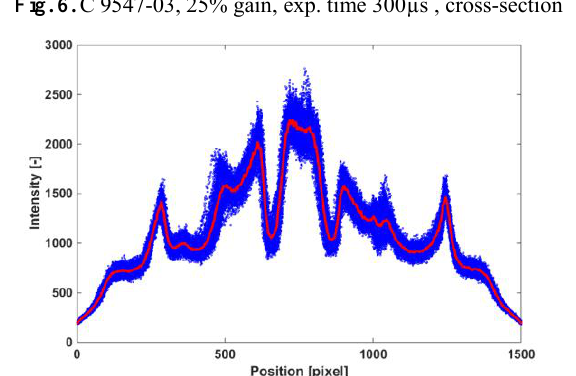
Fig. 6. C 9547-03, 25% gain, exp. time 300µs , cross-section